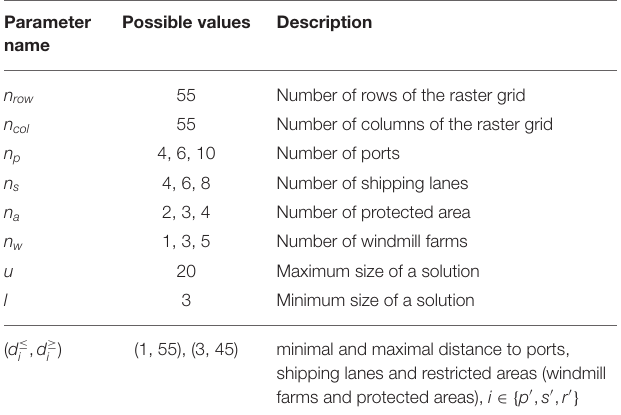
TABLE 1 | Data generation parameters.